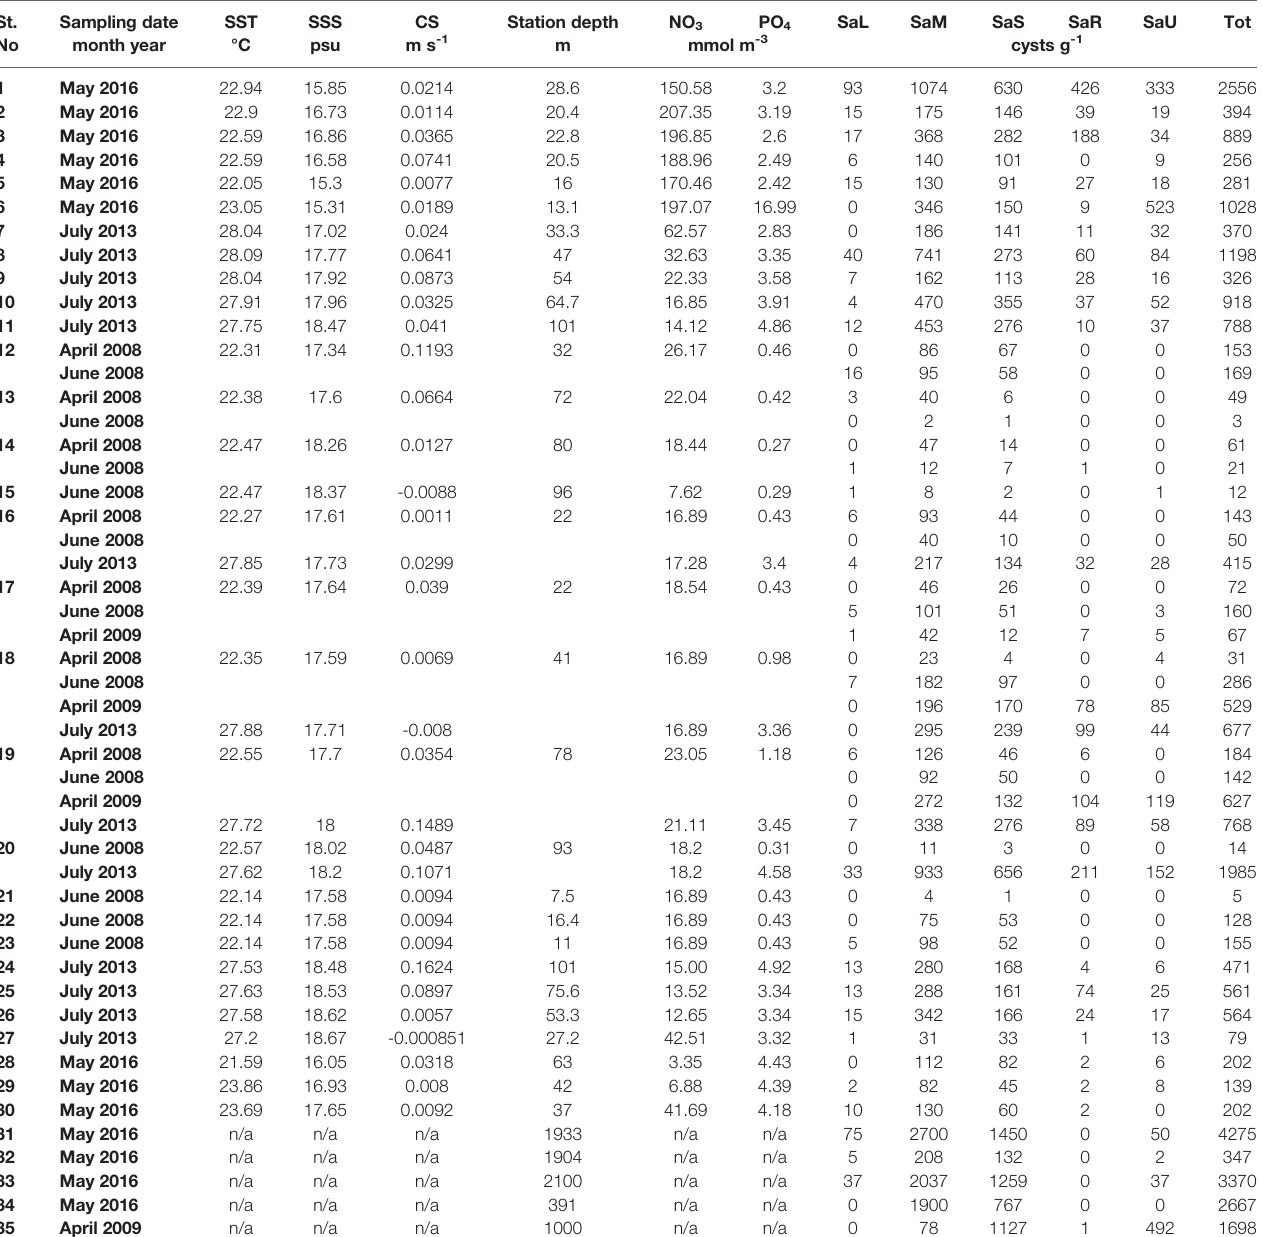
TABLE 2 | Environmental variables (sea surface temperature, SST; sea surface salinity, SSS; currents ’ speed, CS; station depth; nitrates, NO 3 ; and phosphates, PO 4 ) and abundance of viable S. acuminata cyst morphotypes (SaL, S. a cuminata large; SaM, S. acuminata medium; SaS, S. acuminata small; SaR, S. acuminata rough; SaU, S. acuminata uncalci fi ed; Tot , total).